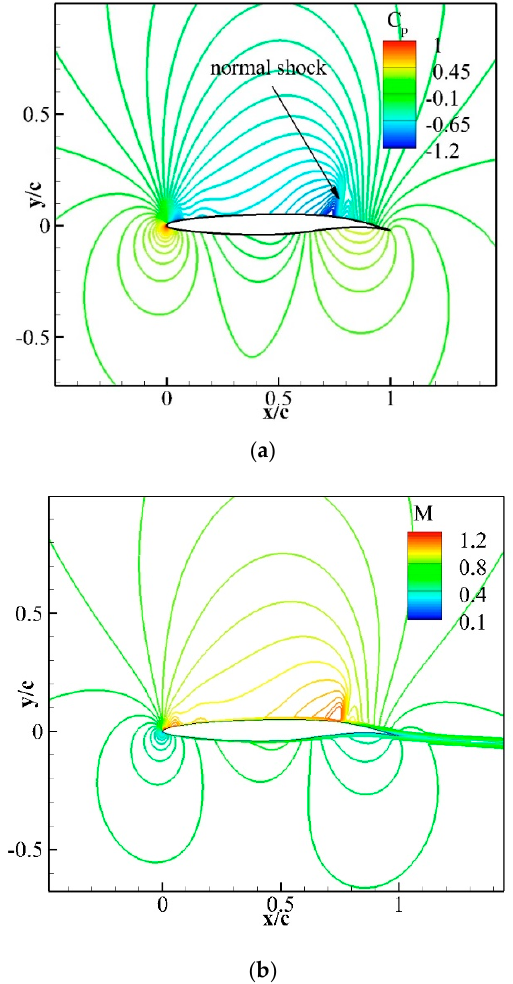
Figure 17. Computed ( a ) coefficient of pressure and ( b ) Mach contours for flow over the VCCTEF 222 airfoil at a zero angle of attack.